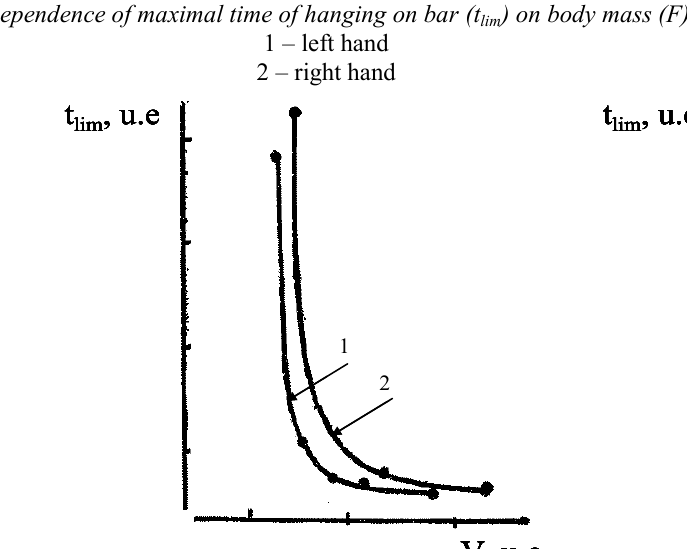
Рис. 3. Dependence of maximal time of work (t lim ) on speed (frequency) V) of movements [9]: 1 – left hand 2 – right